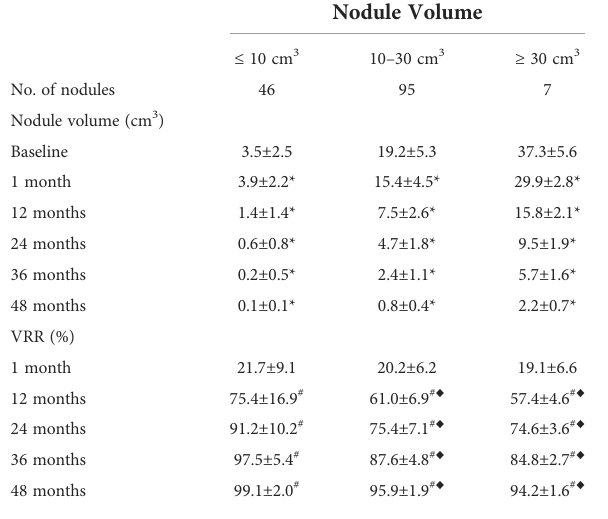
TABLE 3 Nodule characteristics and the effects of MWA at different sizes.